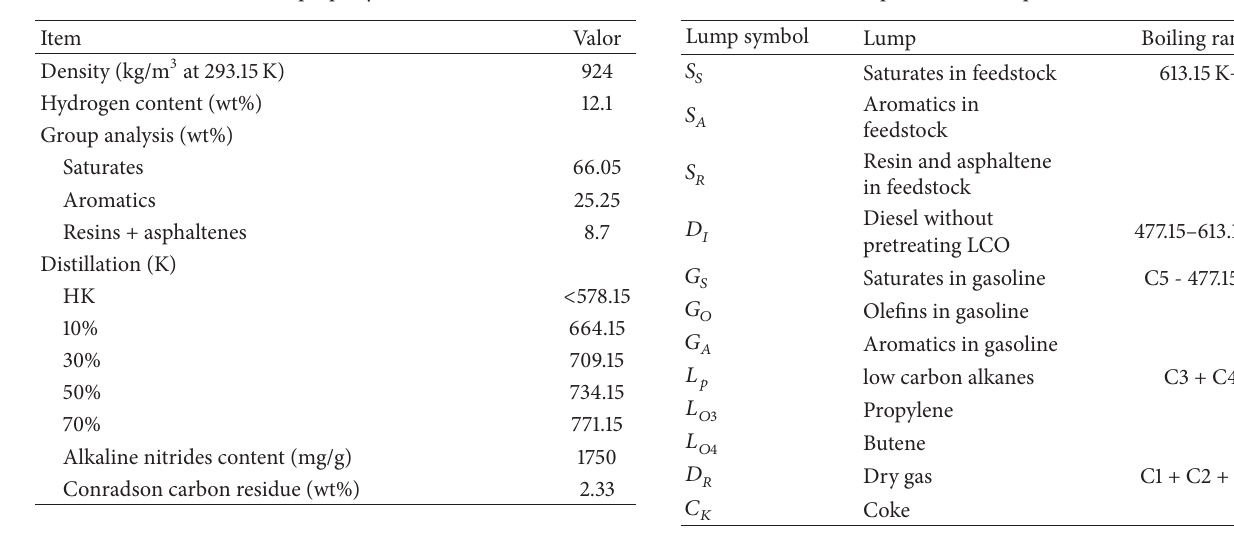
Table 2: The property of feedstock.